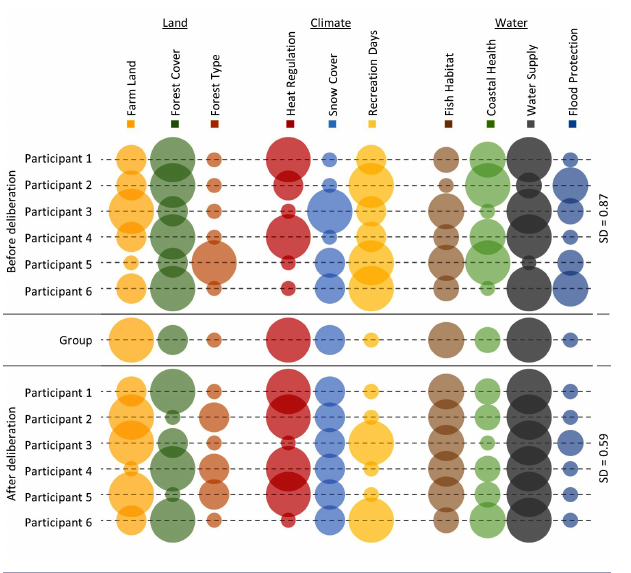
Fig. 1 . Full ranking data from Group 7, corresponding to individual participants before group deliberation (top), the group’s deliberative outcome (middle), and individual participants after group deliberation (bottom). Size of the circles indicates the importance ranking, with large circles being most important. Standard deviations (SD) indicating the degree of disagreement between participant rankings averaged across domains are indicated in the right margin.